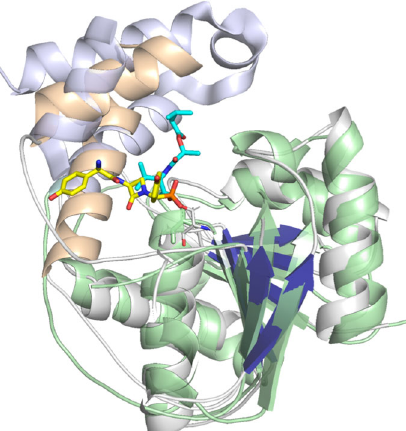
Fig. 7 Superposition of NocTE with VlmTE. Distinct orientations of the ligands are shown with the FP probe 4 directly binding between lid helices α 4 and α 5, while the VlmTE depsipeptide adopts a different orientation that may facilitate the return of the peptide for